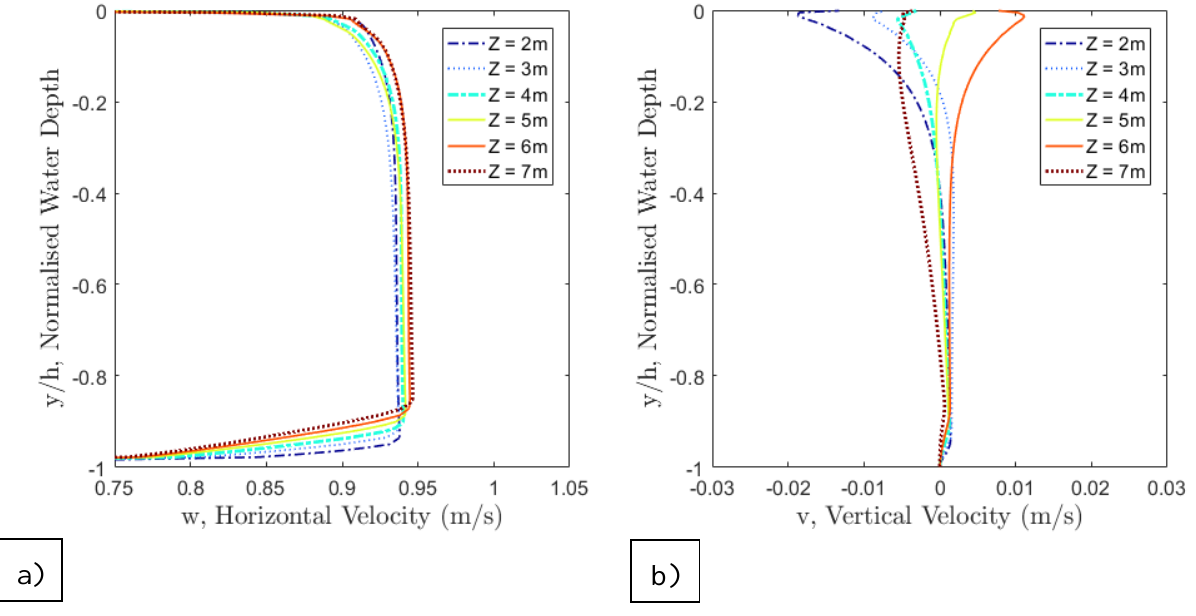
Figure 11. Normalised: a) horizontal and; b) vertical velocities for current only flow through the water depth at 6 different locations on the z-axis at